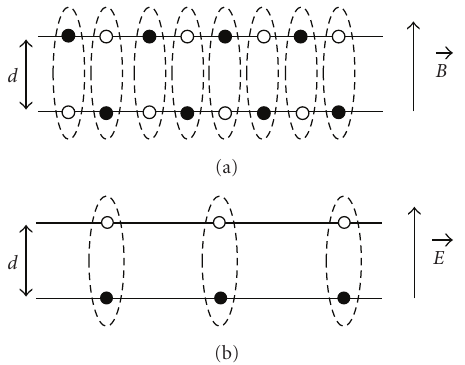
Figure 1: (a) Schematic representaion of the electrons and holes in a Type A bilayer system. (b) Schematic representaion of the electrons and holes in a Type B bilayer